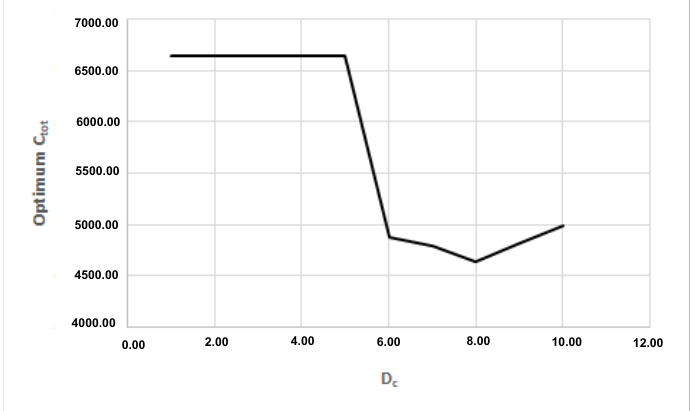
Figure 24. Variations of optimum C tot per D c